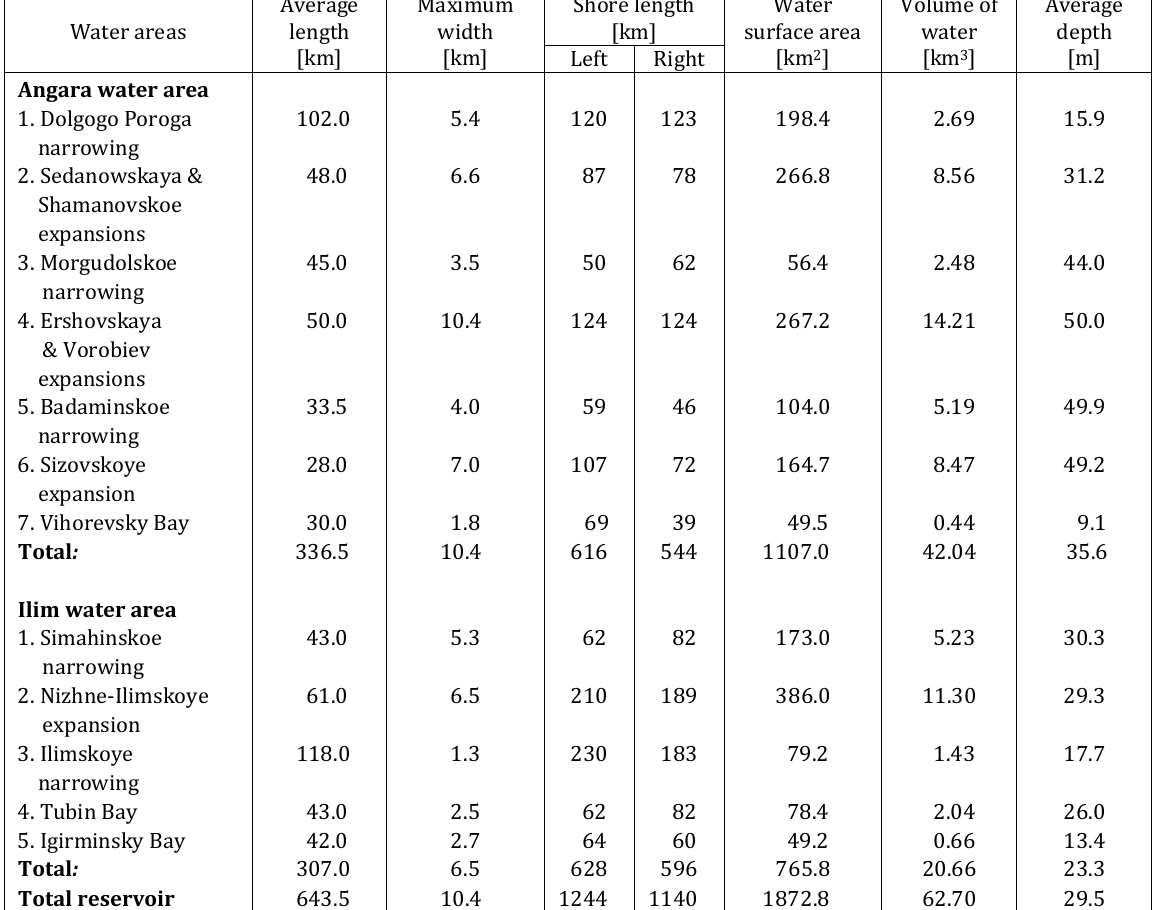
Table 1. Morphometric characteristics of the Ust-Ilimsk water reservoir (after Ovchinnikov, 2003) Water